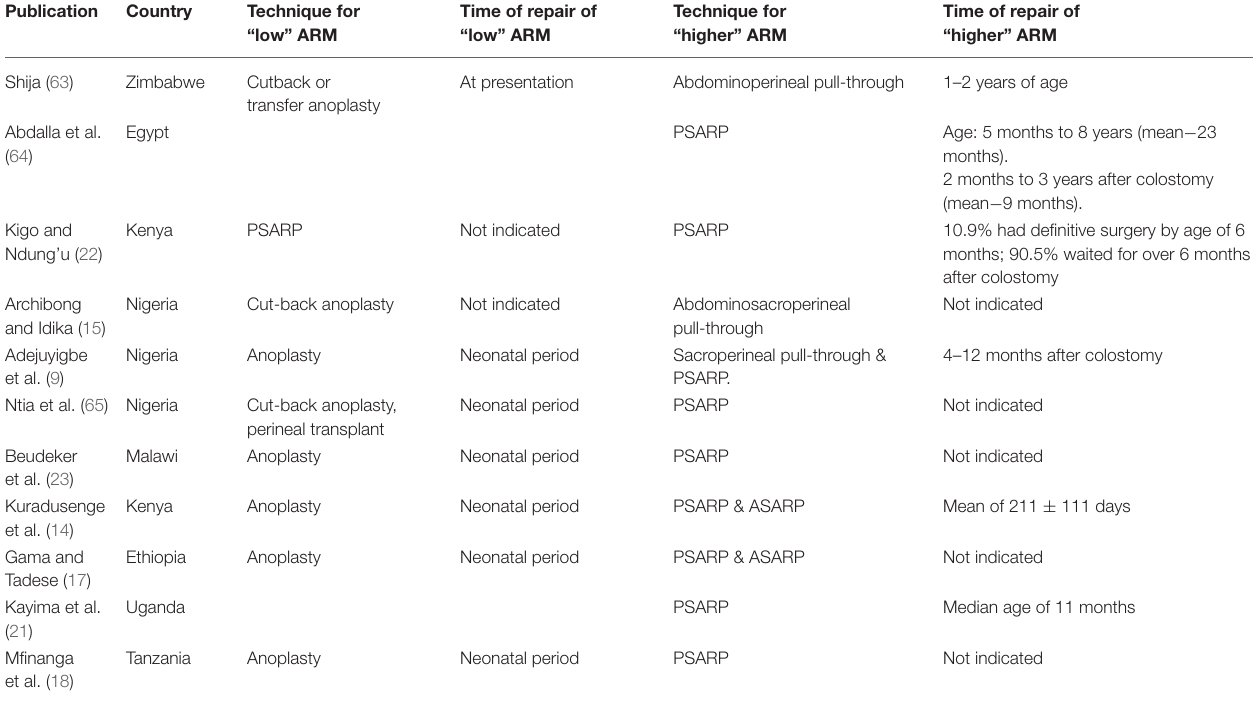
TABLE 1 | Timing and technique of definitive surgery for anorectal malformations in available publications across